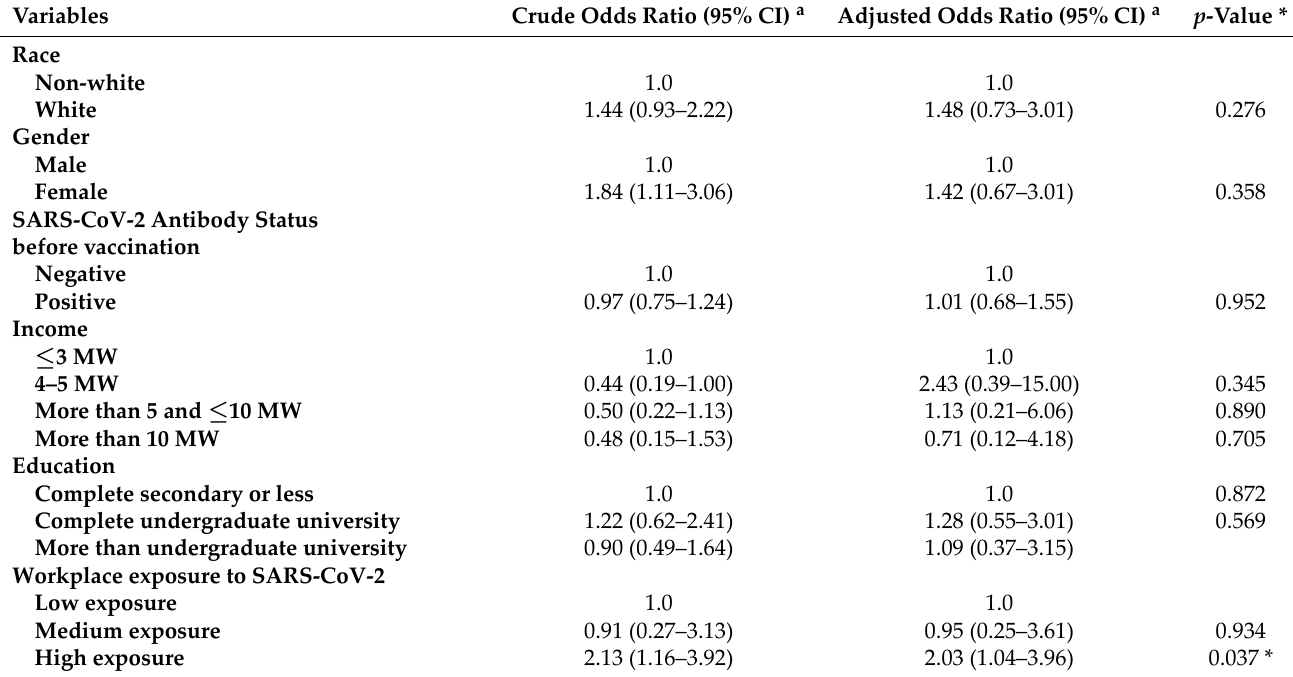
Table 8. Logistic regression of IFF/Fiocruz workforce according to gender and types of work activi‑